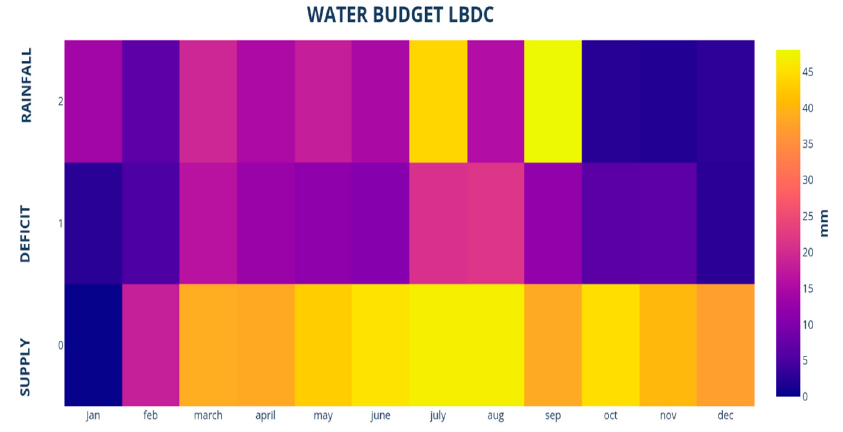
Figure 15. Crop water balance heat map for year 2014 (developed in R-Studio).